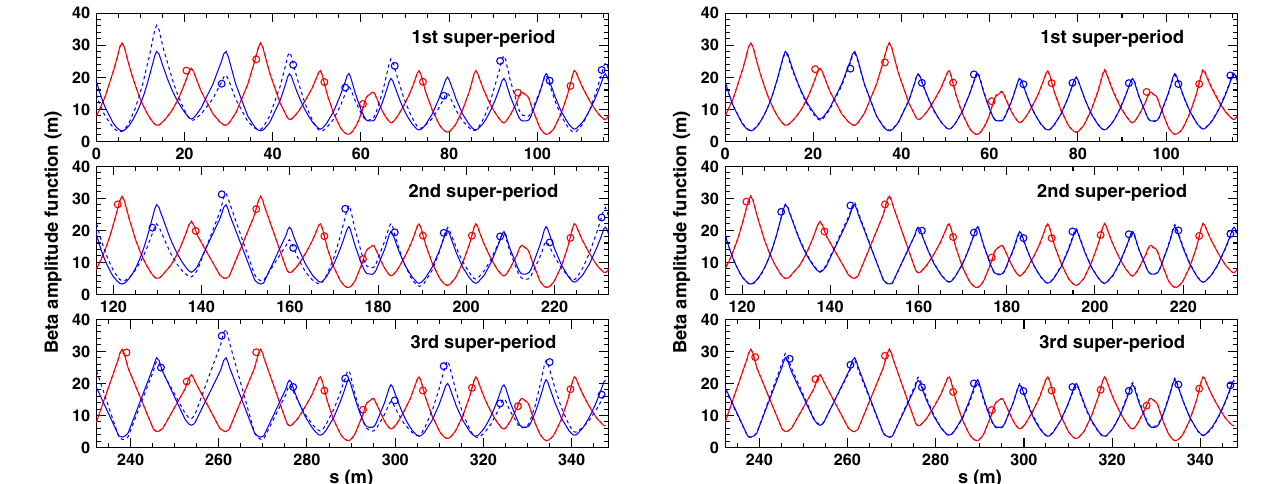
FIG. 7. Horizontal (red circles) and vertical (blue circles) beta functions measured without (left) and with (right) QDTs when the injection bump is active, where the dashed curves are the corresponding calculated results, while the solid ones are the unmodulated beta functions calculated with no injection